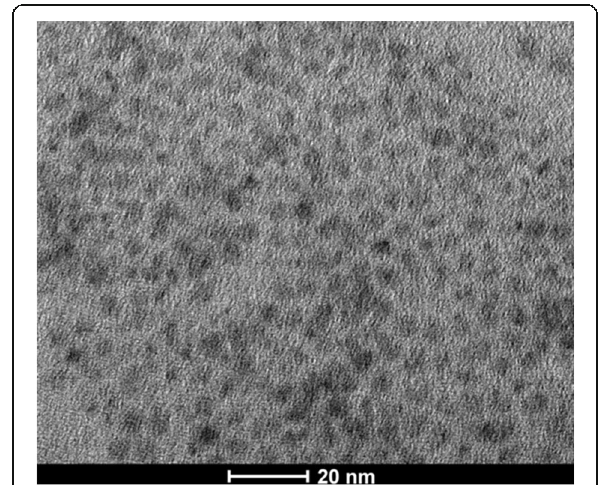
Fig. 1 TEM image of InP/ZnS core/shell QDs